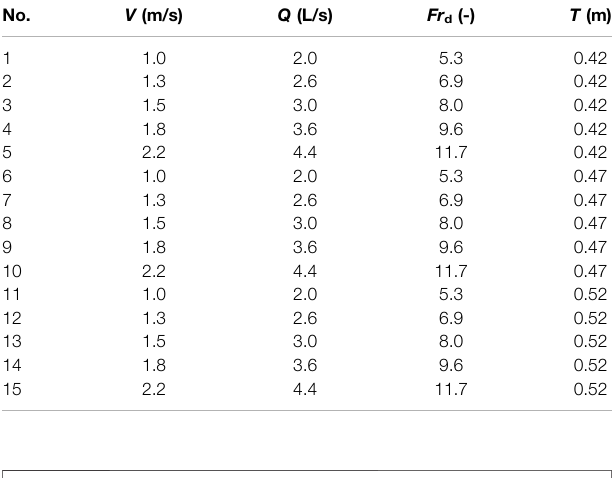
TABLE 1 | Test programs.